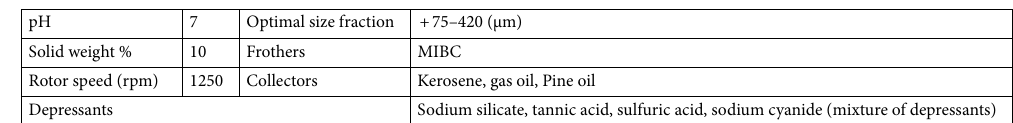
Table 4. Chemical reagents used and conditions for gilsonite flotation